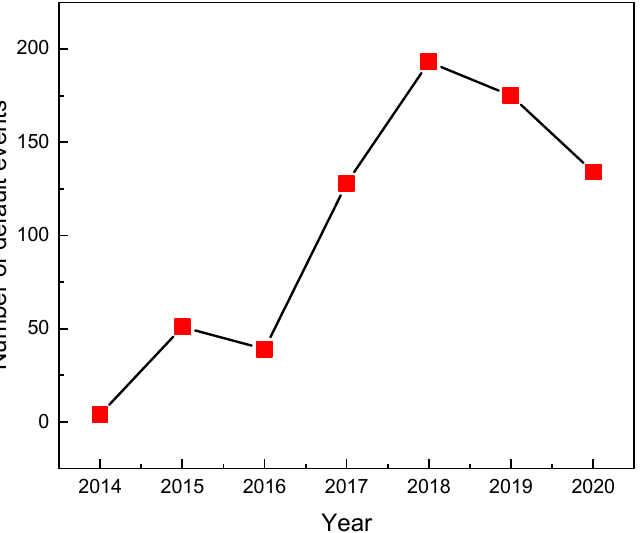
Figure 1. Annual distribution of 724 farmland mortgage default events in China from 2014 to 2020.